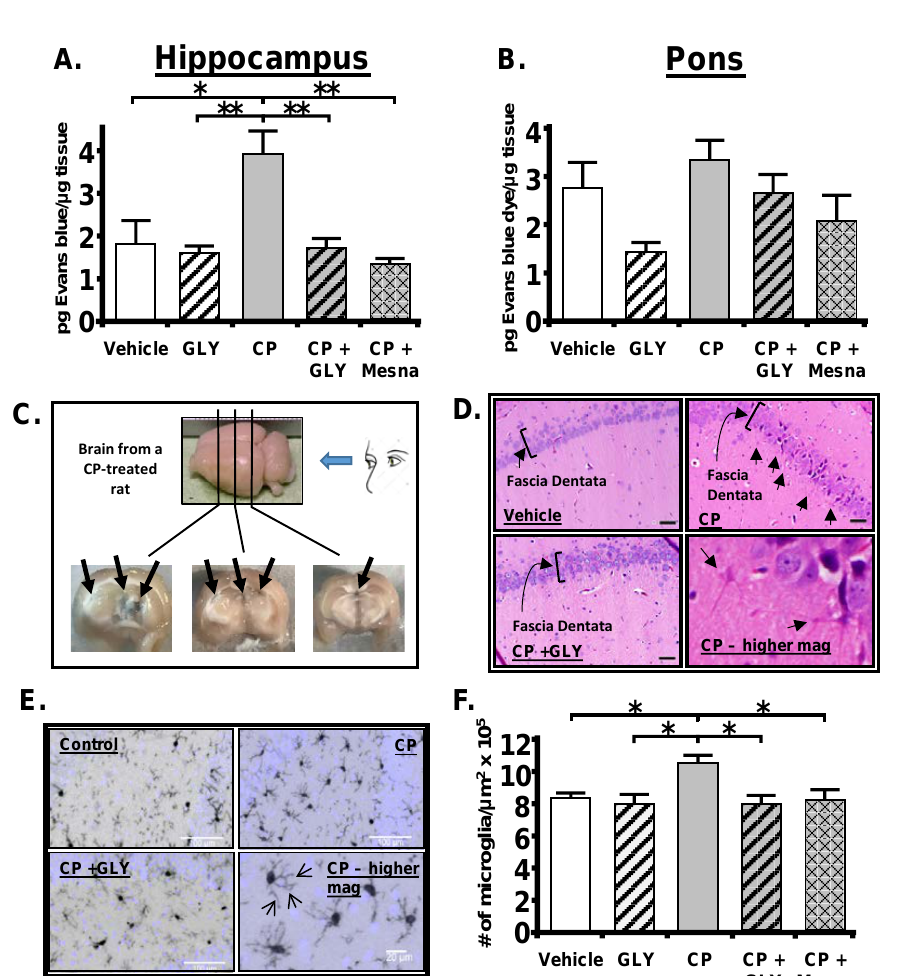
Figure 4. CP-induced cystitis results in inflammation and breakdown of the blood brain barrier in the hippocampus, not in the pons. Administration of GLY or Mesna blocks this effect. ( A ). Evans blue extravasation was increased in the Hippocampus by CP. This increase was prevented by treatment with Gly or Mesna. All results were calculated as pg of Evans blue per µ g of tissue. Bars represent mean ± SEM. For A: Vehicle: n = 3; GLY: n = 3; CP: n = 4; CP + GLY: n = 4; CP + Mesna: n = 4. For B: Vehicle: n = 4; GLY: n = 3; CP: n = 4; CP + GLY: n = 4; CP + Mesna: n = 8. * p < 0.05, ** p < 0.01 by one-way ANOVA and Student-Newman-Keuls post-hoc analysis. ( B ). Evans blue extravasation was not significantly changed in the pons by any treatment. ( C ). CP-induced cystitis results in areas of gross blood brain barrier breakdown, with Evans blue dye apparent (arrows) in the periventricular region of the hippocampus. A CP-treated rat was injected with Evans blue as described in the Methods section. After 1 h the brain was removed, sectioned coronally with a scalpel at the approximate locations indicated and photographed. ( D ). CP results in an NLRP3-dependent increase in number of microglia-like cells within the fascia dentata of the hippocampus. Coronal sections (10 µ m) were cut through the hippocampus and an H&E stain was performed using routine methodical techniques. Slides were visualized at 60 × . Activated glial cells are indicated by arrows. ( E ). Immunohistochem- istry shows increased density of activated microglia within the fascia dentata. Coronal sections (10 µ m) were cut and Immunohistochemistry was performed using an anti-IbA1/AIF1 antibody and routine histological methods. Slides were visualized at 20 × and the number of microglia was quanti- tated. Arrows demonstrating increased glial processes (arrows) at higher magnification are shown. ( F ). Density of Microglia. Results are depicted as the number of microglia per µ m 2 . Bars represent mean ± SEM. [Vehicle: n = 5; GLY: n = 6; CP: n = 7; CP + GLY: n = 4; CP + Mesna: n = 8]. * p < 0.05 by one-way ANOVA and Student-Newman-Keuls post-hoc analysis. This figured was reprinted, with permission from the American Physiological Society, from